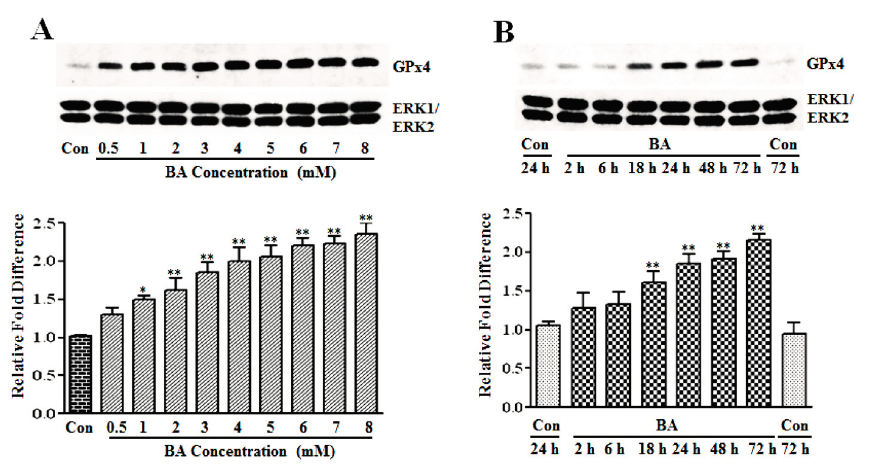
Figure 3. Assessment of the butyrate effect on GPx4 protein expression in